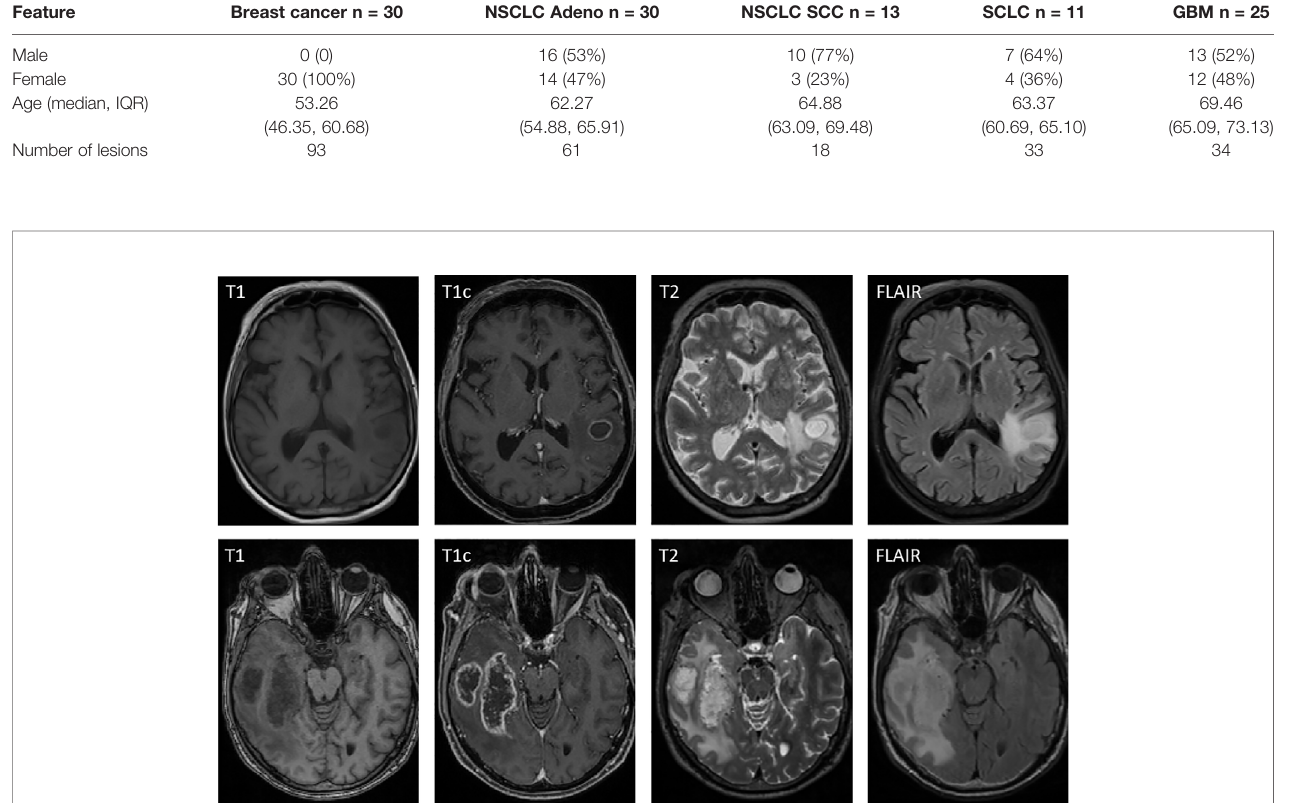
TABLE 1 | Characteristics of included patients (n = 109) with fi ve different histological tumor types (breast cancer, NSCLC Adenocarcinoma, NSCLC SCC, SCLC, GBM). Feature